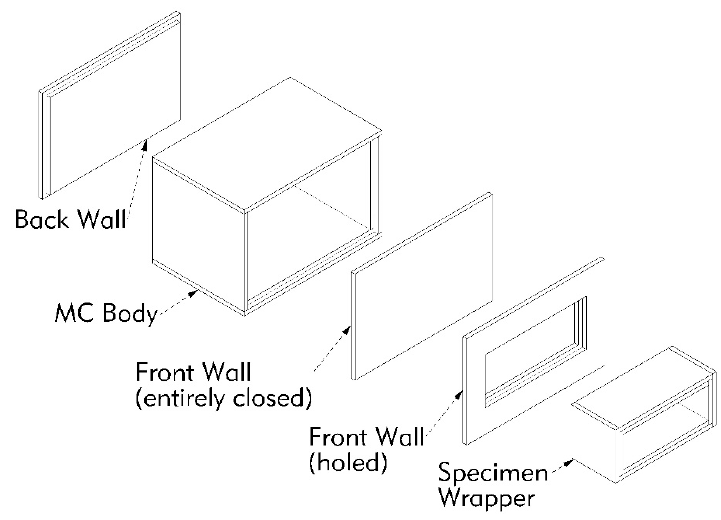
Figure 2. Exploded view of the MC.